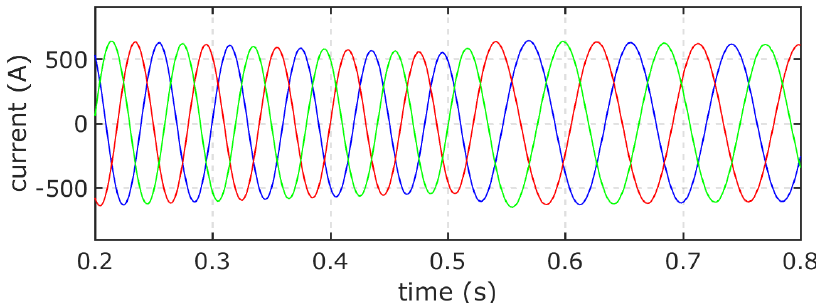
Figure 14. Rotor currents response to a frequency step at constant wind speed and load (phase a-red; phase b-green; phase c-blue).